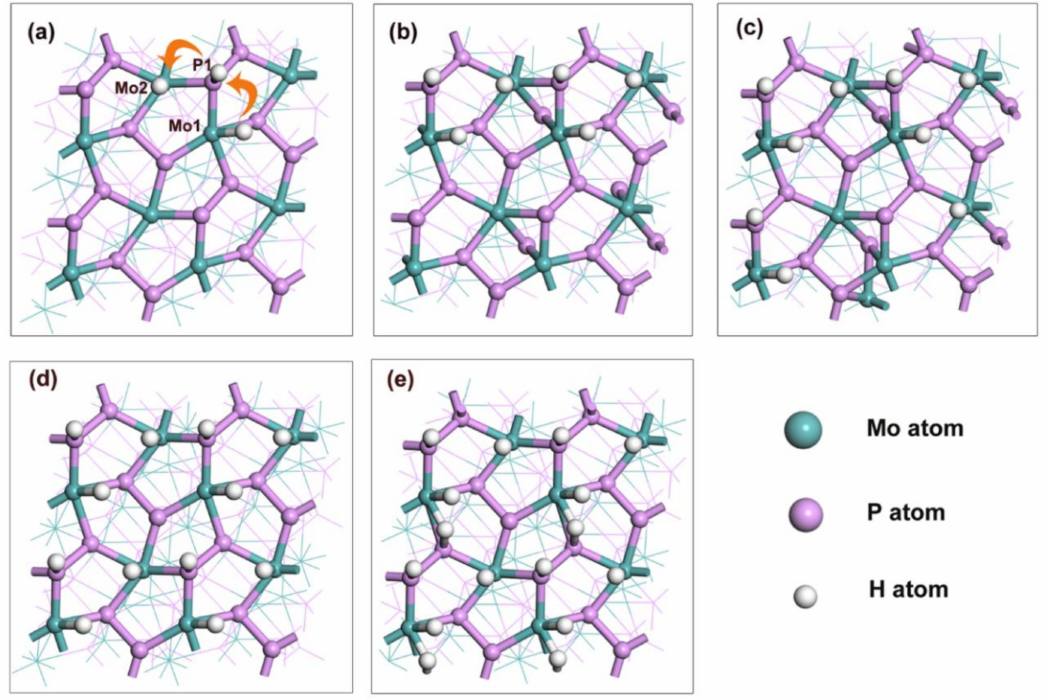
Figure 3. Optimized structures of the (111) facet with the H coverages: ( a ) 18.75%, ( b ) 37.5%, ( c ) 56.25%, ( d ) 75% and ( e )